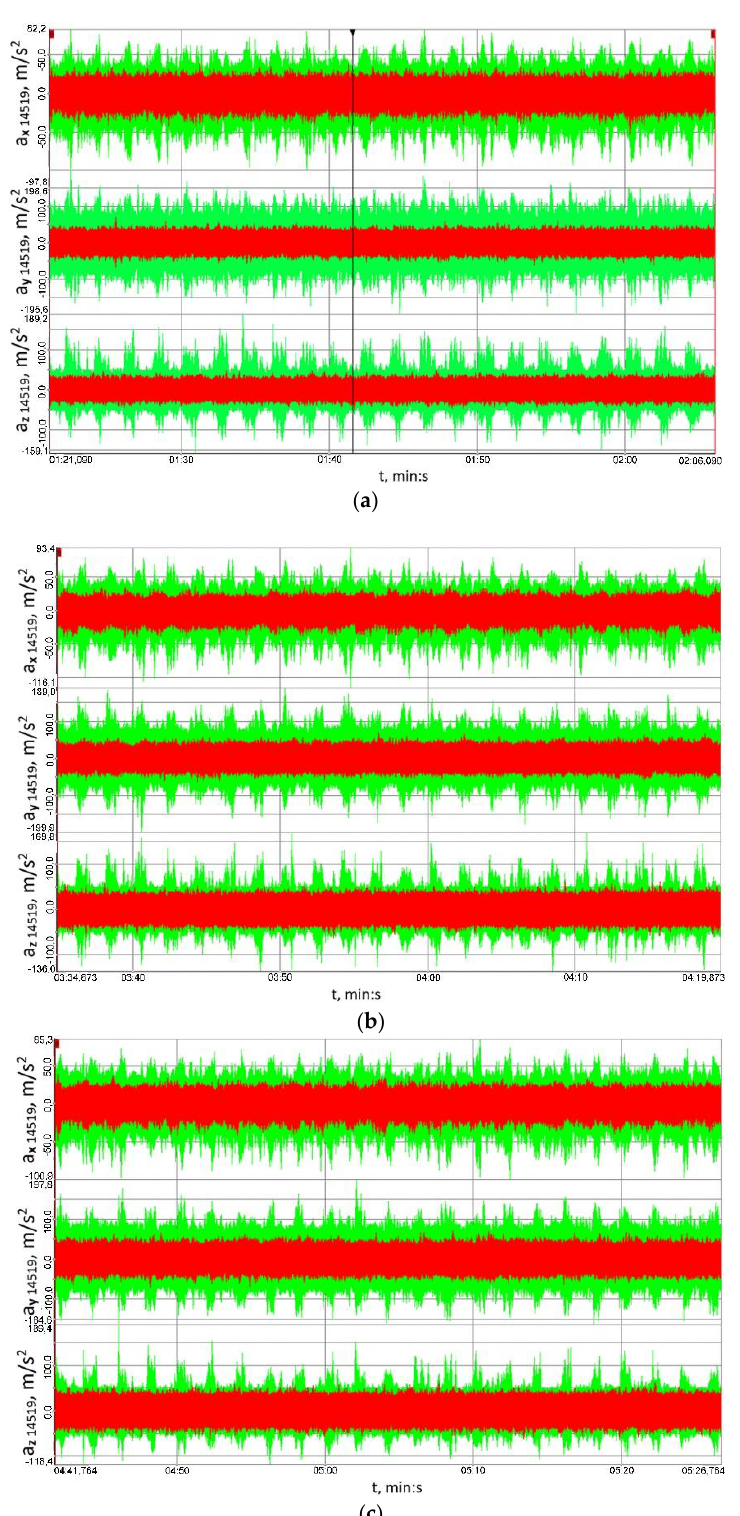
Figure 12. Time histories of the vibration accelerations recorded in three mutually perpendicular measurement directions using transducer No. 14519 (Figure 7) attached to the housing of the output shaft bearing in the multi-stage reduction gear: ( a ) 41.8 ± 27.9 Nm, ( b ) 79.2 ± 55 Nm, ( c ) 114.8 ± 75.9 Nm; red colour marks the results obtained for the flexible operation mode of the clutch; green colour corresponds to the locked operation mode.